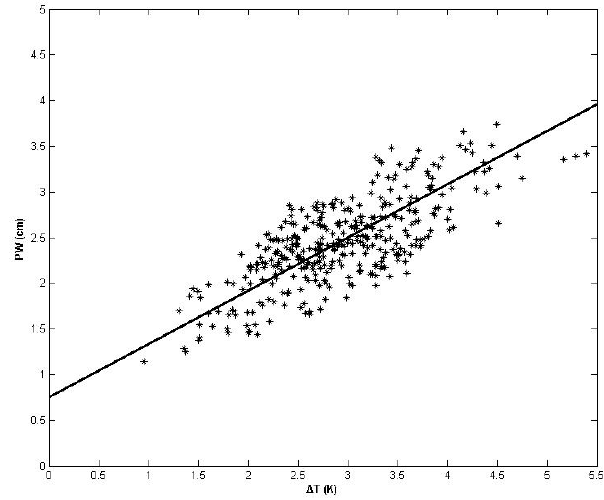
Fig. 2. Scatterplot of MODIS derived PW versus AVHRR derived Δ